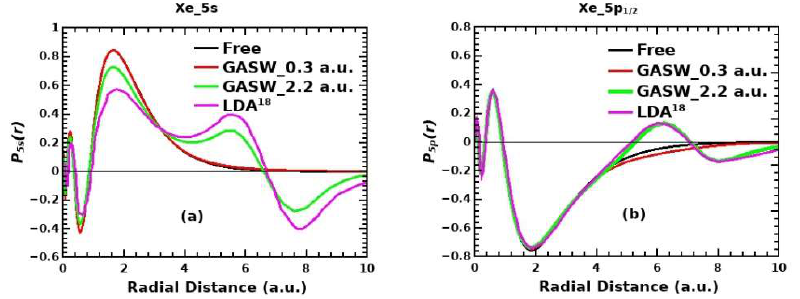
Figure 11. The large component of (a) 5s and (b) 5p 1/2 radial wavefunctions of free and confined Xe.